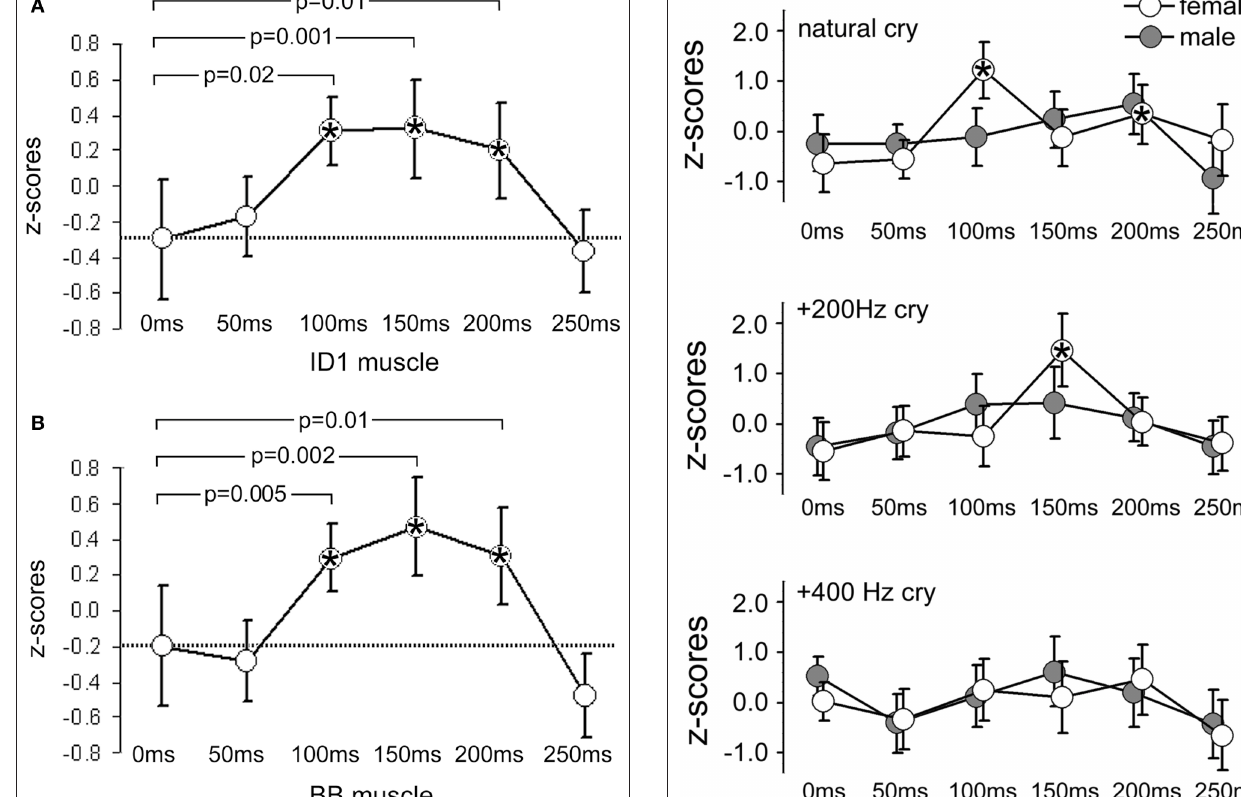
of ISI, F (5 , 90) = 5.34, p = 0.0002, η 2 = 0.09, illustrated in